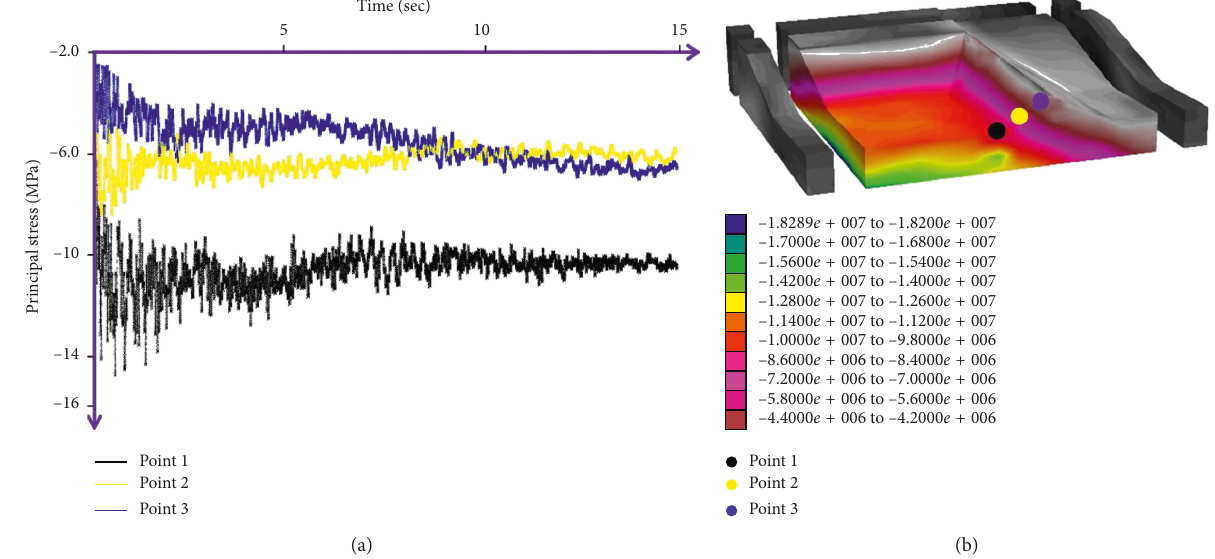
Figure 22: (a) Principal stress-time graphic for the San Fernando earthquake. (b) Contour plot diagram for 15 th second of the San Fernando